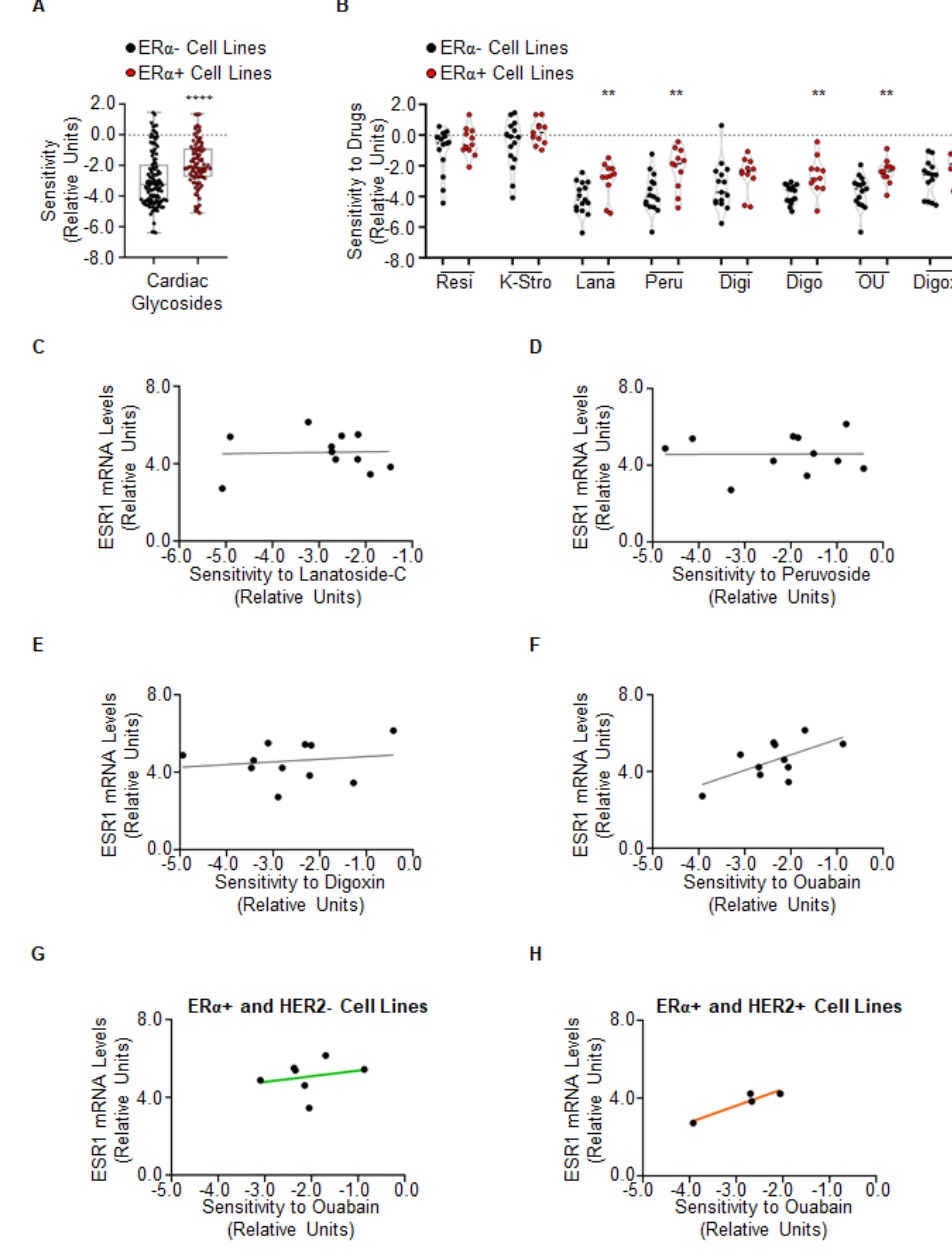
Figure 1. Analysis of cardiac glycosides in breast cancer cell lines. Plots in ( A , B ) have been generated by using the data in the DepMap portal. Each dot of the plots refers to the value of the specific parameter in a single breast cancer cell line. For details, please see Supplementary Table S1. **** ( p < 0.0001) and ** ( p < 0.01) indicate significant differences calculated with the Student t -test. ( C–F ) Linear regression between sensitivity to the indicated cardiac glycosides and ER α mRNA expression in ER α -positive breast cancer cell lines. ( G , H ) Linear regression between sensitivity to ouabain (OU) and ER α mRNA expression in breast cancer cell lines classified as luminal A (LumA- green) or luminal B (LumB-orange). For a detailed explanation of the dataset used, please see the text. For details, please see Supplementary Table